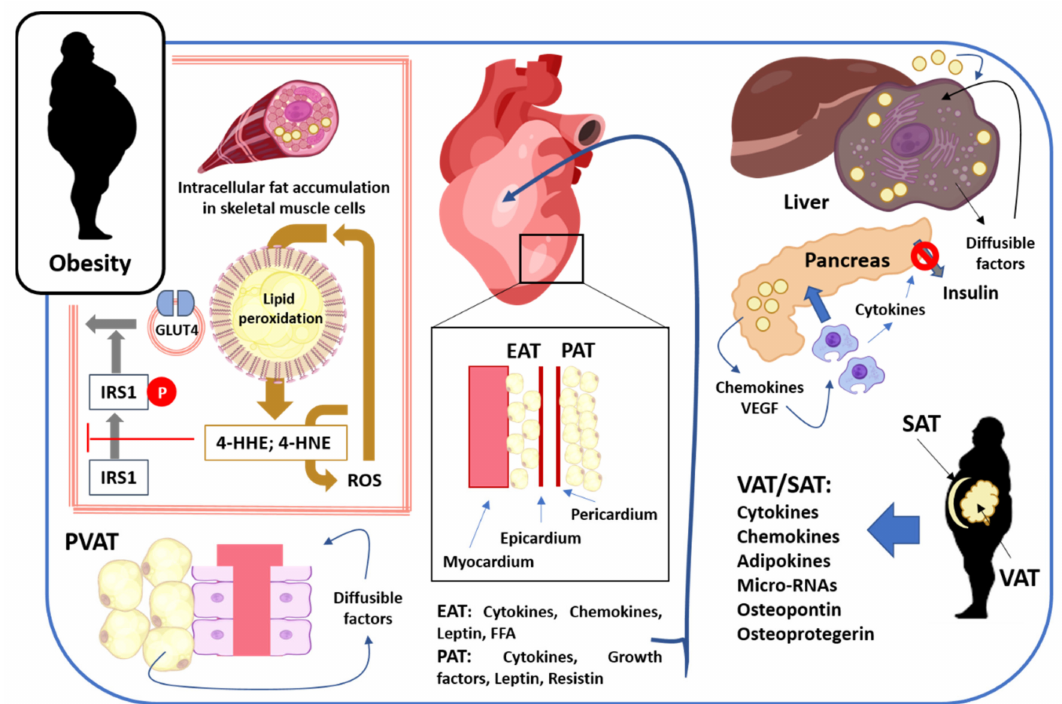
Figure 1. Overview effects of adipose tissue in obese subjects. In skeletal muscle, fat accumulates inside muscle fibers, causing a dysregulation of cellular metabolism and favoring lipid peroxidation. The peroxidation of intracellular lipid droplets triggers the appearance of 4-HNE and 4-HNE, two mediators that interfere with IRS1 phosphorylation, thereby interrupting the transport of vesicles loaded with the GLUT4 transporter to the muscle membrane. Physiologically, insulin, by binding to its receptor, favors IRS1 phosphorylation and GLUT4 expression in skeletal muscle fibers. Therefore, lipid peroxidation ultimately causes insulin resistance. The adipose tissue that accumulates around the blood vessels (PVAT) secretes a variety of diffusible factors with vasomotor, vascular remodeling, pro- and anti-inflammatory, as well as pro- and anti-atherogenic effects. Adipose tissue also accumulates in the heart, both at the epicardial and pericardial levels (EAT and PAT, respectively). This cardiac adipose tissue secretes cytokines, chemokines, adipokines, growth factors, and FFAs, which indicate cardiomyocyte physiology, causing changes in heart function. In obese subjects, adipose tissue also accumulates in the liver and pancreas. In hepatocytes, the accumulation is intracellular, causing insulin resistance, in-creased hepatic lipogenesis, and the secretion of diffusible factors with effects on the hepatocytes themselves, promoting the functional changes described. In the pancreas, adipose tissue accumulates outside the pancreatic cells, and secretes chemokines and VEGF that promote macrophage infiltration into the pancreatic tissue. These macrophages secrete cytokines that interfere with insulin secretion. Finally, another characteristic of obese subjects is the accumulation of subcutaneous and visceral adipose tissue (SAT and VAT, respectively), preferably in the abdominal region. This adipose tissue secretes a multitude of diffusible factors, which exert effects on various body tissues and organs. Thus, in obese subjects, there is a crosstalk between adipose tissue and other body tissues and organs mediated by diffusible factors with local or generalized effects. For details, see text. Source for figure illustrations: https://scidraw.io/ (accessed on 8 September